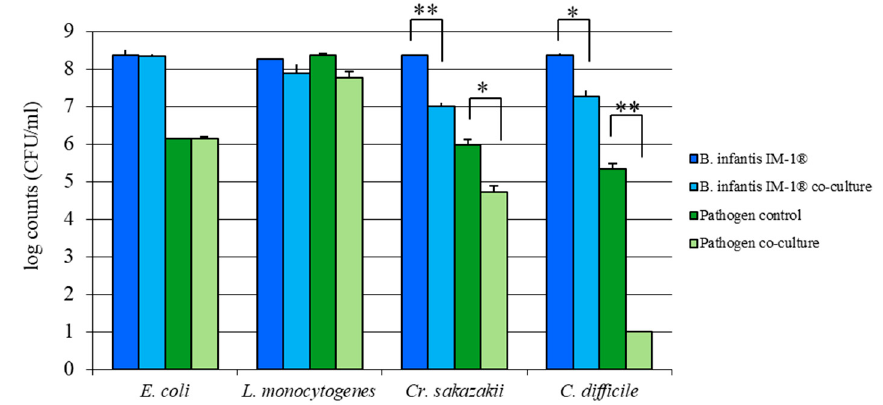
Figure 2. Mean log counts (CFU/mL) and standard deviations of enteropathogenic strains ( E. coli LMG 2092, L. monocytogenes LMG 13305, Cr. sakazakii LMG 5740 and C. di ffi cile LMG 21717; LMG 2092 , L. monocytogenes LMG 13305, Cr. sakazakii LMG 5740 and C. difficile LMG 21717; pathogen co-culture) and B. infantis IM-1 ® strain ( B. infantis IM-1 ® co-culture) after 24 h of co-culture in the